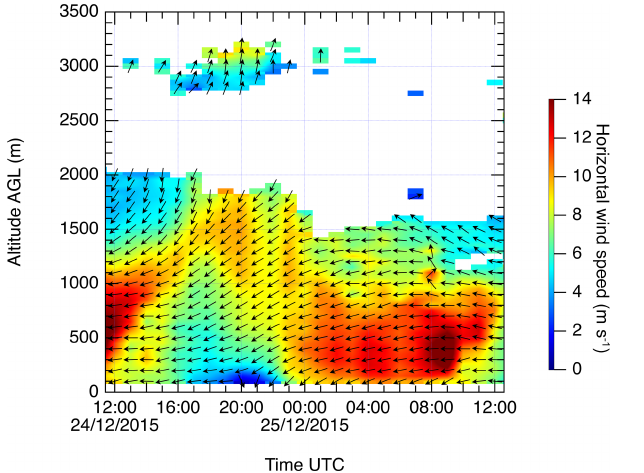
Figure 5. Time–height section of the logarithmic range-corrected lidar signal (in arbitrary units) deduced from the Doppler lidar